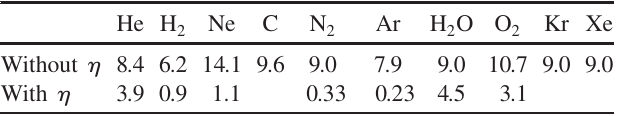
TABLE II. Maximum energy (in keV) at which a stable equi- librium can be established in a frictional cooling scheme for (cid:1) þ with and without accounting for effective charge for several stopping media. A blank entry means no equilibrium energy can be established.